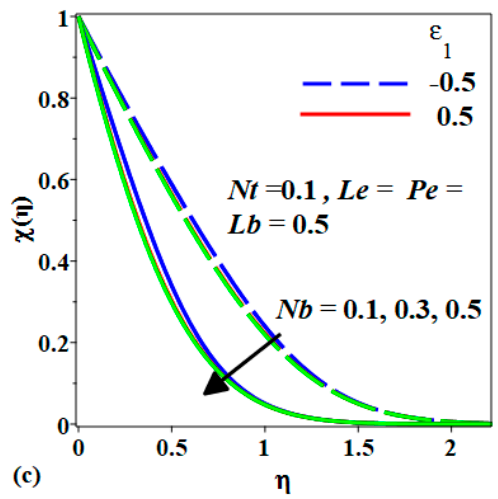
Figure 2. Variation of Nb and